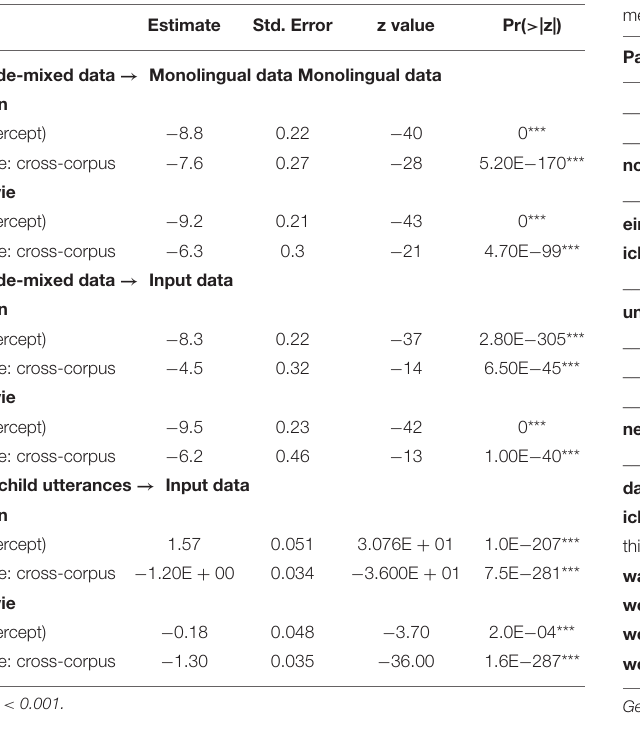
TABLE 1 | Coefficients of mixed-effects logistic regression models fit to the traceback data.